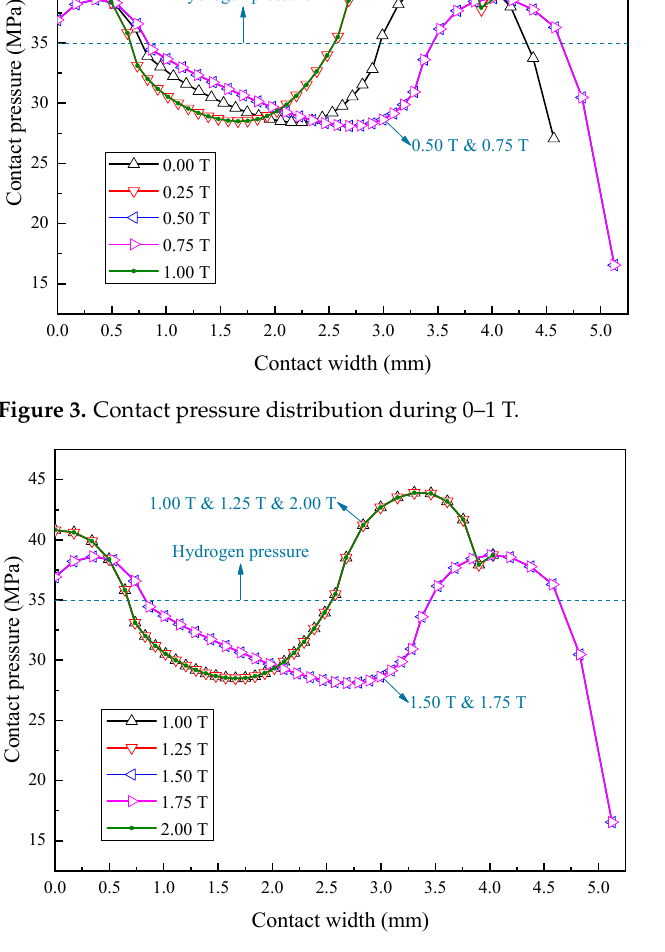
Figure 4. Contact pressure distribution during 1–2 T. Figure 5 displays the Mises stress distribution of the X-ring during 0–2 T. At 0 T, the Mises stress is symmetrically distributed. There are grain-shaped stress concentration zones in the X-ring’s lower left and right corners. The peak Mises stress is located in the lower right corner of the X-ring, and the height of the upper left and right sealing lip ( h 0 and h 1 ) of the X-ring is the same. Starting at 0.25 T, the Mises stress of the X-ring is no longer symmetrically distributed. During 0–0.25 T, the cover moves along − y , generating − y friction on the X-ring. Depending on the friction, the cover drags the X-ring to move together along − y . Due to the dragging effect of the cover, the upper right sealing lip of the X-ring moves down slightly, and the angle between the stress concentration zone in the lower right corner of the X-ring and the upper surface of the wedge-ring ( θ 2 ) decreases slightly. As the wedge-ring firmly blocks the X-ring, the − y displacement of the area in the lower right corner of the X-ring is 0. Since the rubber material is approximately incompressible, the area in the lower right corner of the X-ring is squeezed by the upper area, resulting in a significant increase in the Mises stress values of the stress concentration zone in the lower right corner.